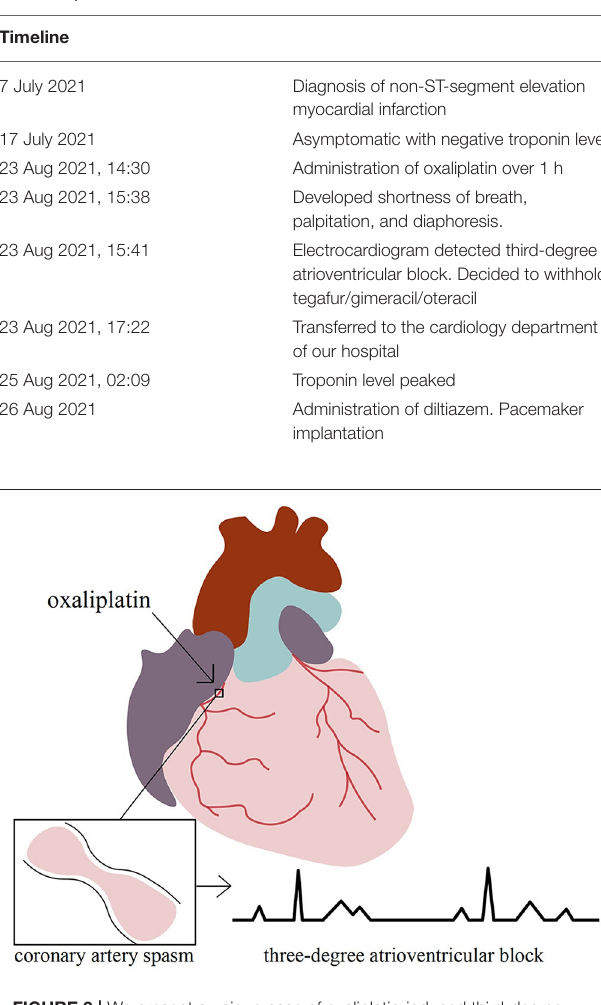
TABLE 1 | Timeline for the